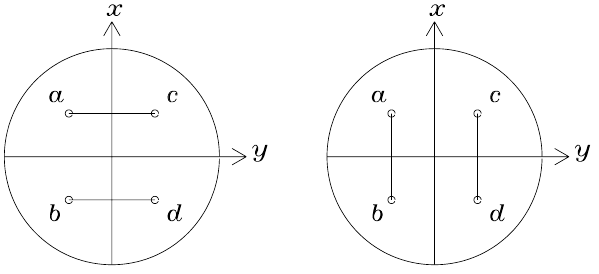
Fig. 4. Four sectors of the ADV collector and their connections in pairs, as it is seen from the entrance diaphragm. The ratios of the currents collected by pairs a – c and b – d (left-hand panel) or a – b and c – d (right-hand panel) give a possibility to derive the deviation of the ion bulk velocity from the analyser’s z -axis along the x - or y -axis,